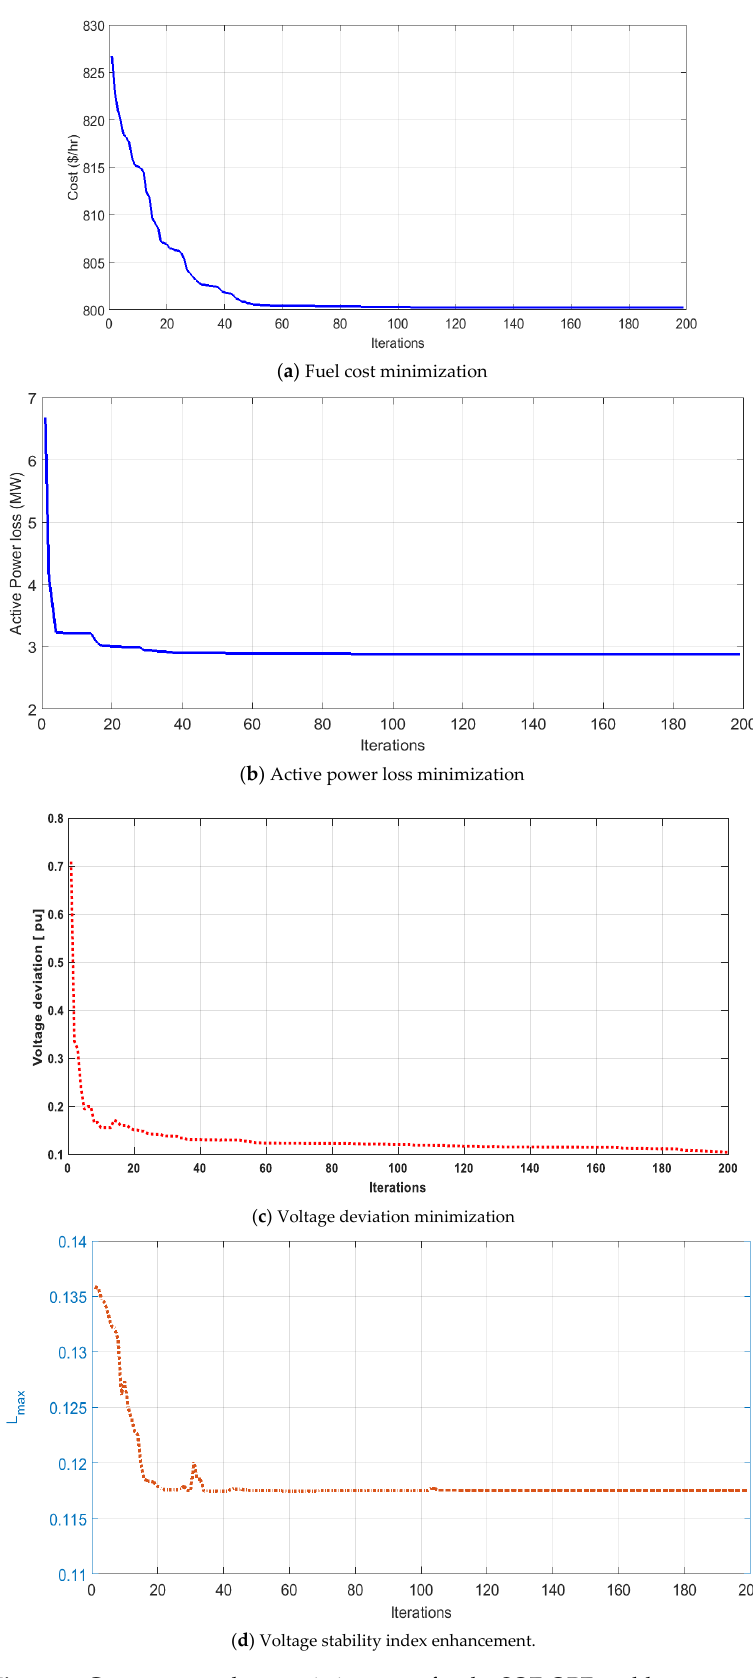
Table 6. Comparison of SOF based OPF achieved by various optimization techniques